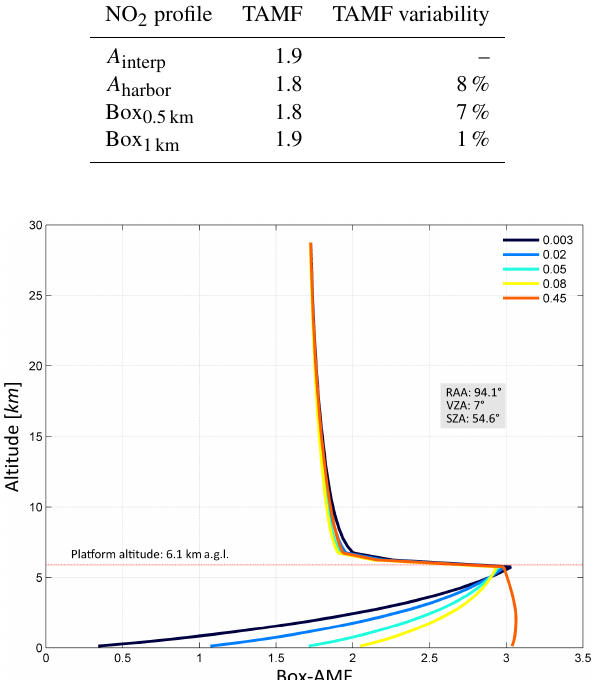
Figure 10. BAMF profiles illustrating the vertical sensitivity of the APEX instrument to NO 2 . The high impact of the surface albedo, mainly on the lowest atmospheric layers, is shown based on five different scenarios, ranging from low to high albedo. Scenarios are based on the minimum, µ − 1 σ , mean, µ + 1 σ and maximum albedo in the Antwerp data set.